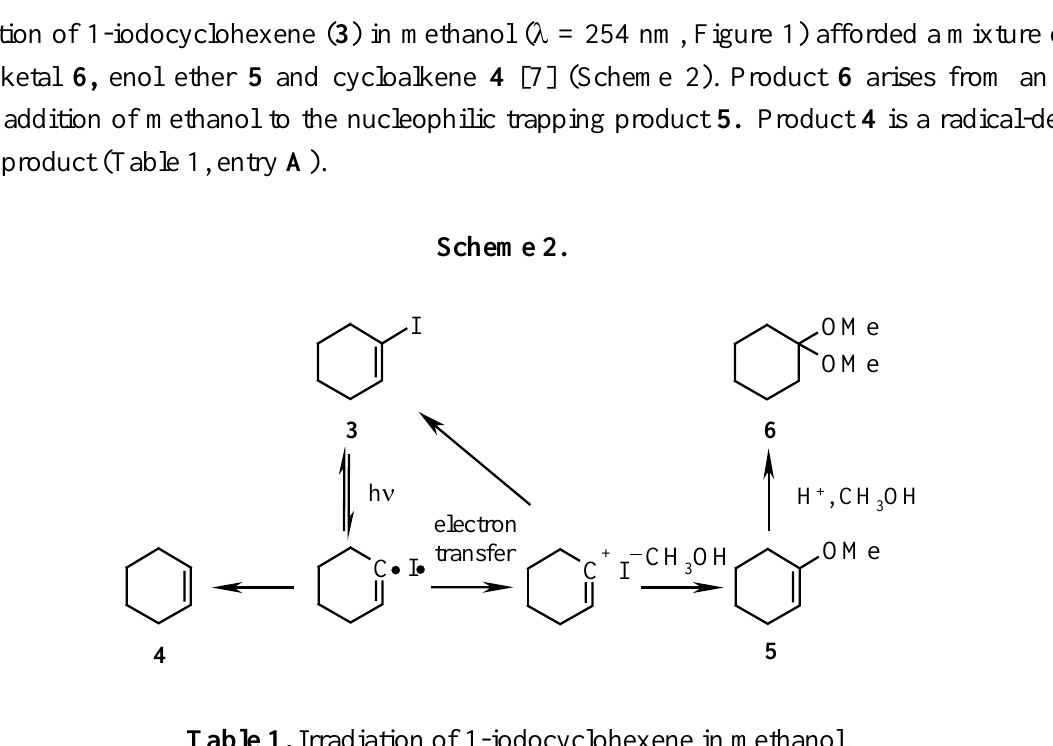
Table 1. Irradiation of 1-iodocyclohexene in